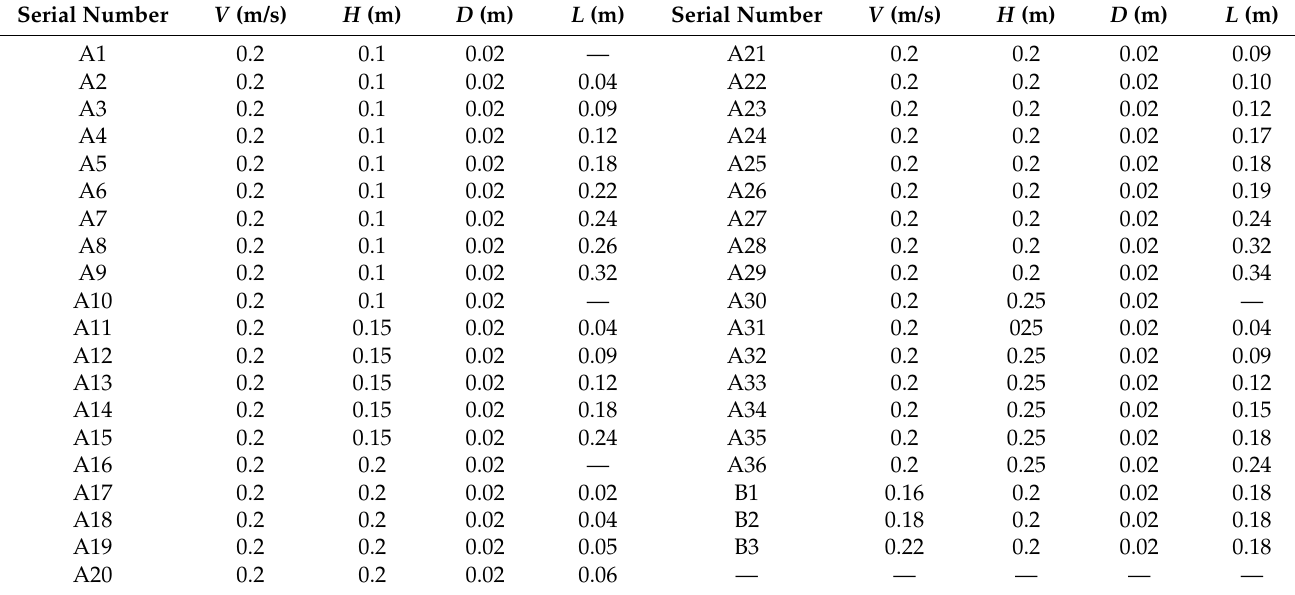
Table 1. Experimental conditions and